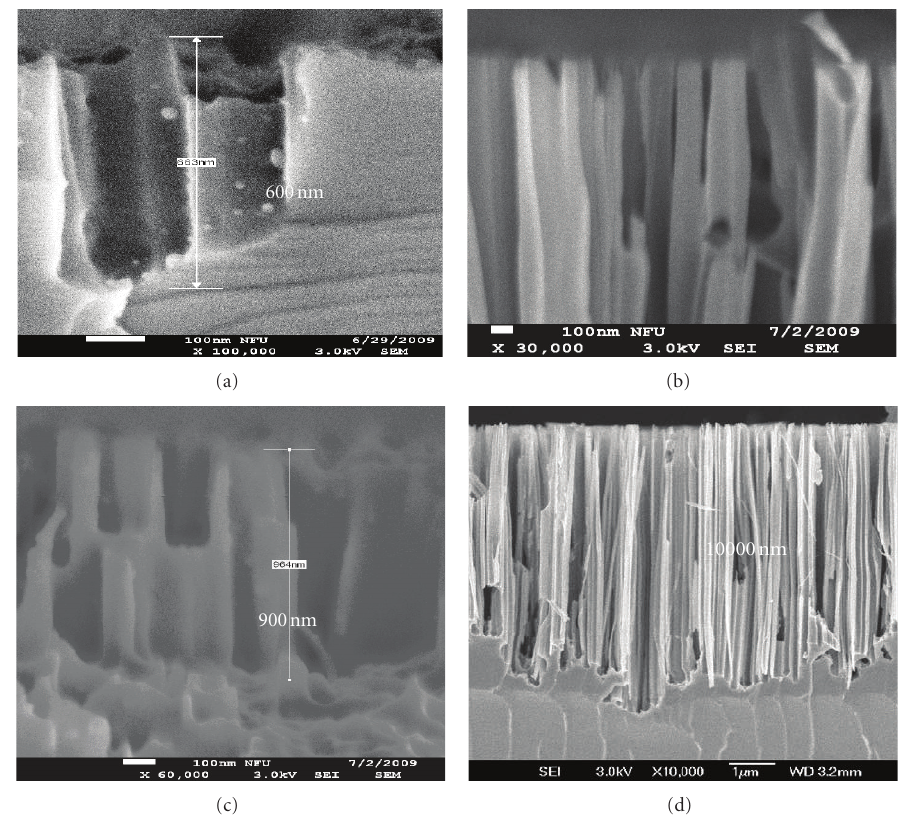
Figure 4: SEM images of various SNW/p-Si(100) structures. Etching conditions were aqueous AgNO 3 /HF/H 2 O mixture chemical solution in a ratio of 4:34 :162 (volume) at 25 ◦ C for (a) 1.5, (b) 1.5 (enlargement of (a)), (c) 3, and (d) 30min. The concentration of AgNO 3 was